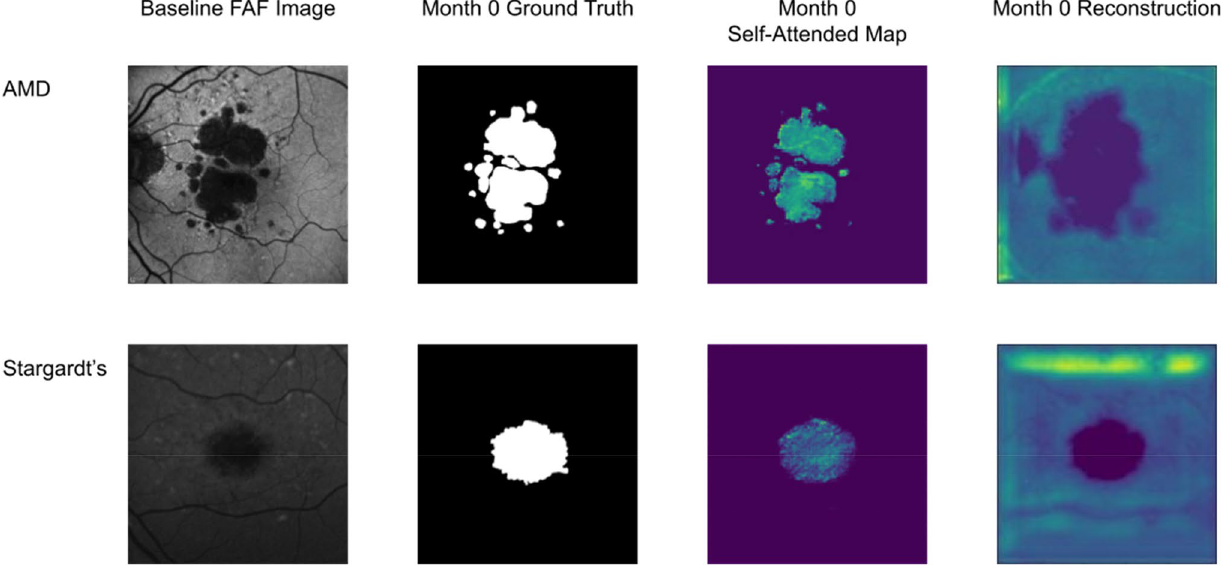
Figure 5. Illustration of the reconstruction and self-attended maps based on the baseline atrophy segmentation in the last downsampling layer.